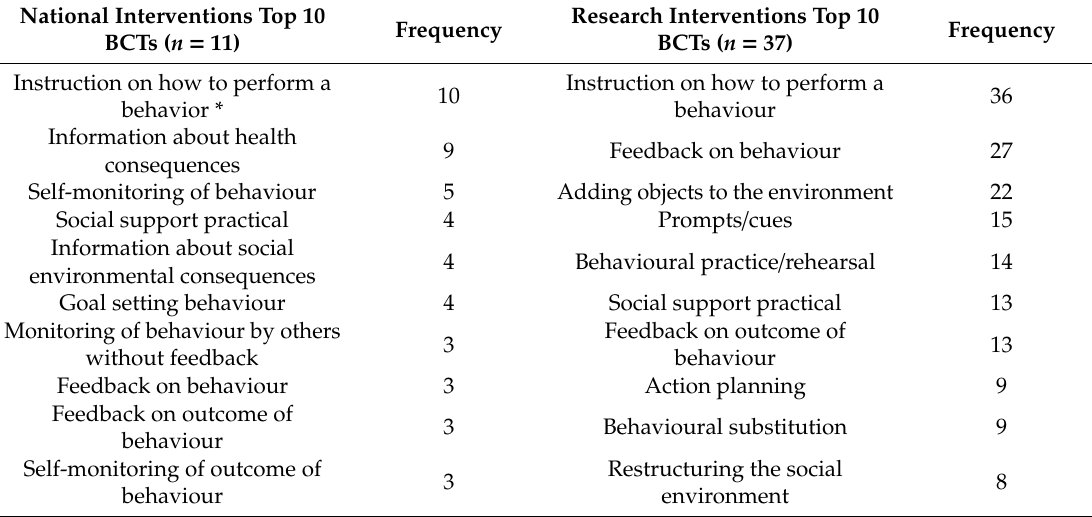
Table 2. Ten most frequently identified BCTs in national and research interventions. National Interventions Top